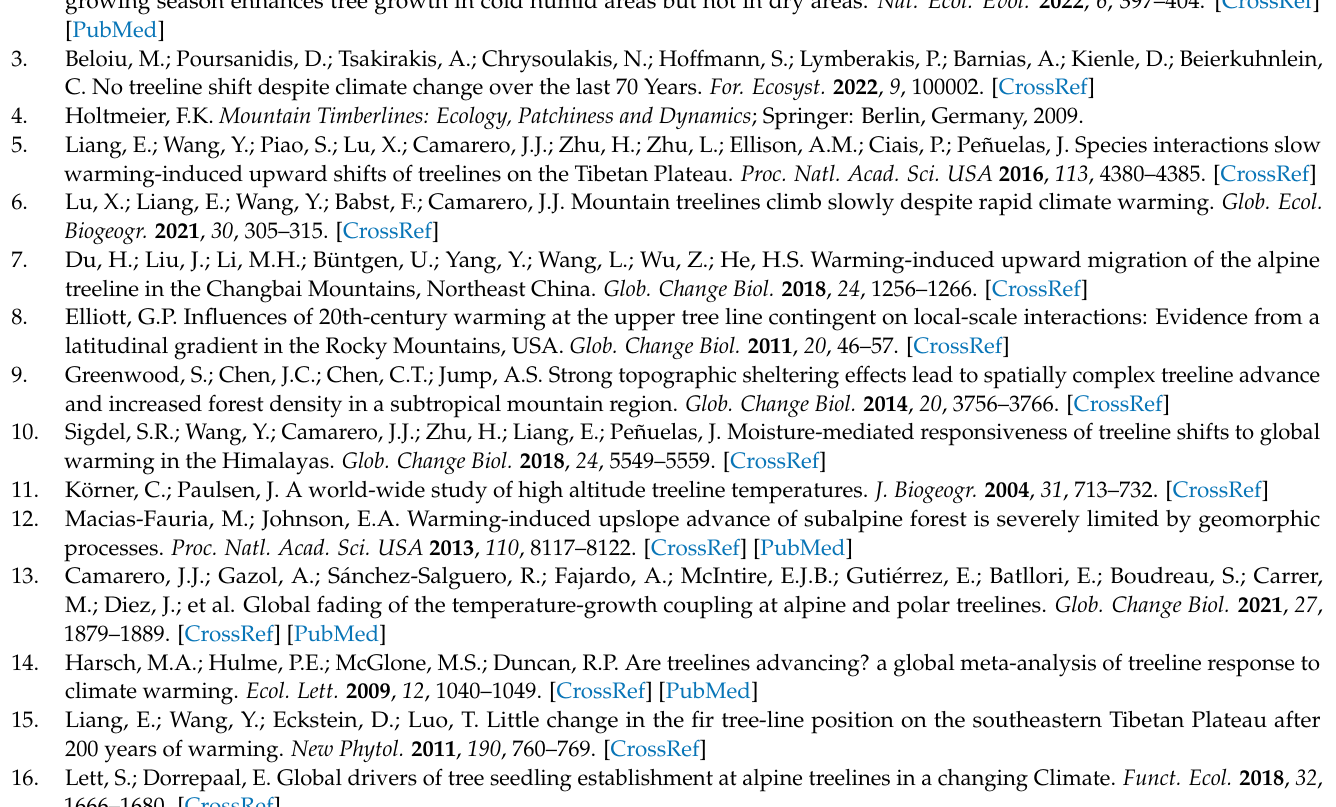
Table S3. Definitions of the biotic variables and three terminologies used in this